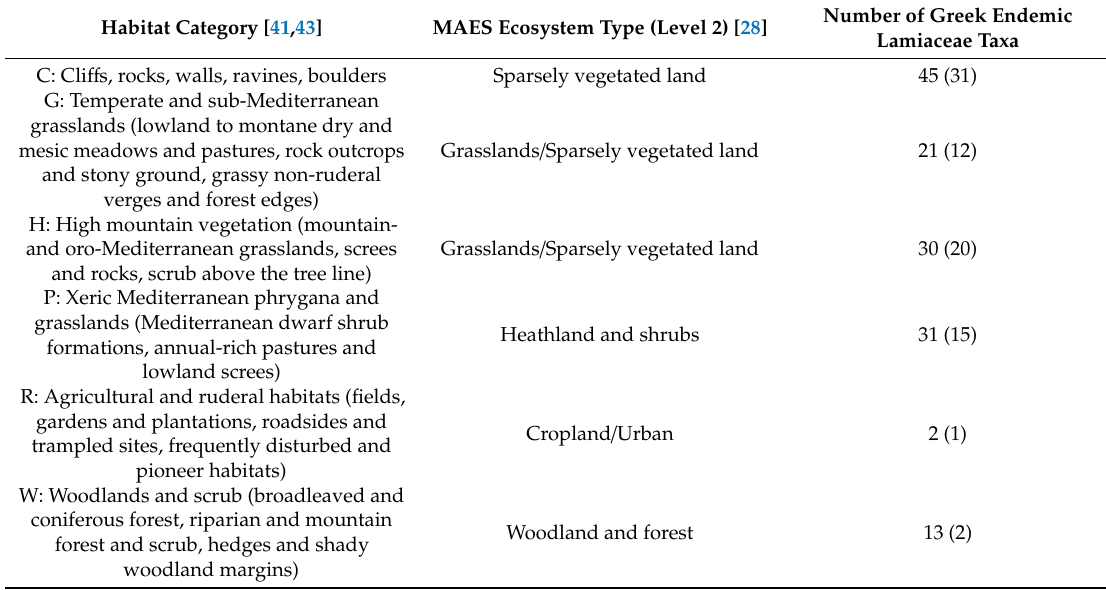
Table 3. Number of Greek endemic Lamiaceae taxa per habitat category and Mapping and Assessment of Ecosystems and their Services (MAES) ecosystem type (level 2). Numbers in the parenthesis indicate number of taxa exclusively present in the corresponding habitat